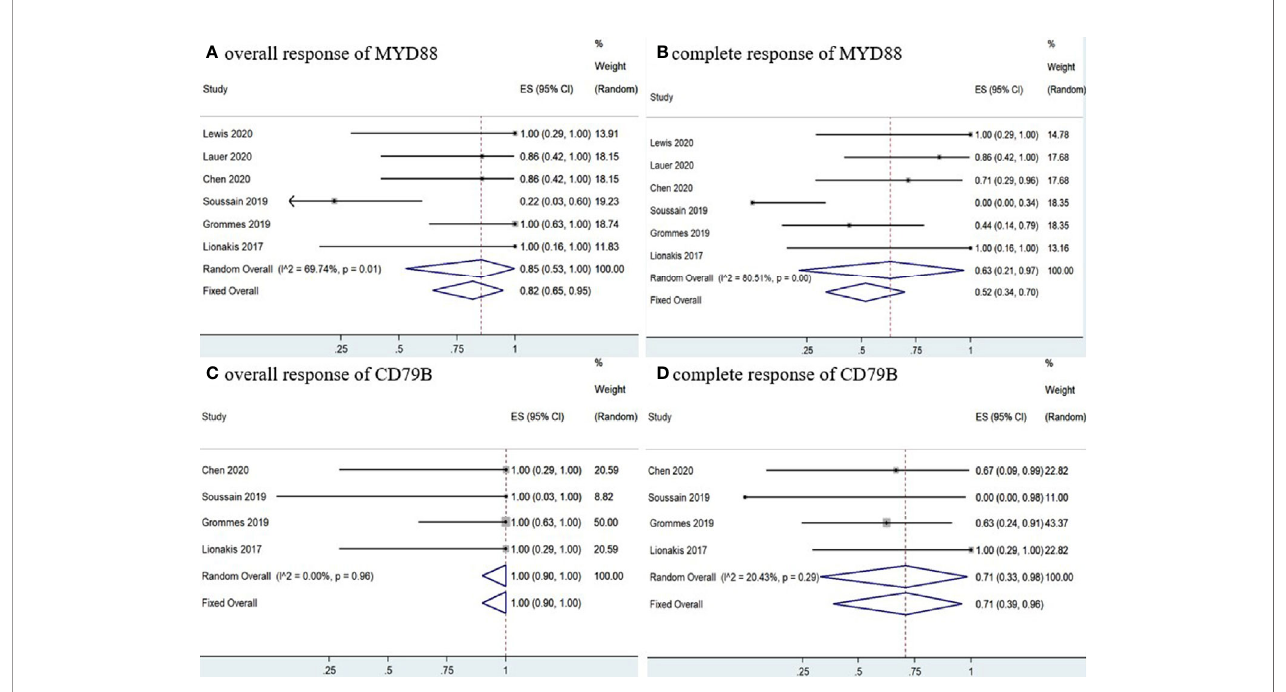
FIGURE 8 | Pooled response rates of MYD88 mutation and CD79B mutation. (A) Pooled overall response rate of MYD88 mutations. (B) Pooled complete response rate of MYD88 mutations. (C) Pooled overall response of CD79B mutations. (D) Pooled complete response of CD79B mutations.